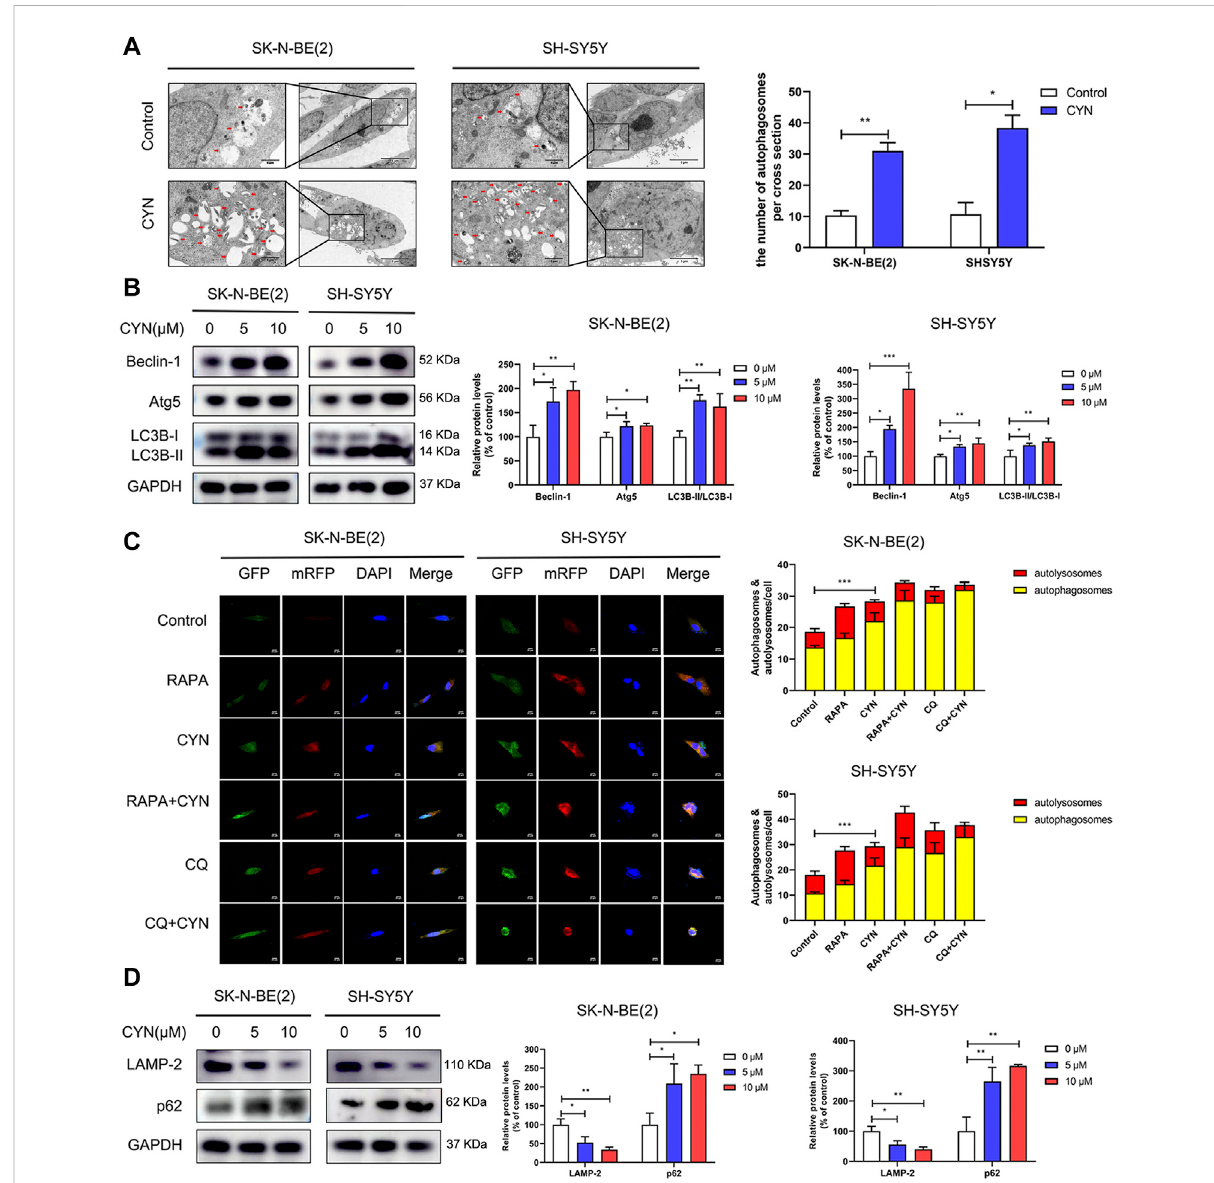
FIGURE 3 Effects of CYN on the autophagy level in NB cells. (A) Transmission electron microscopy (TEM) was utilized to observe the ultrastructure of NB cells, and the arrows indicate autophagosomes. (B) The expression levels of autophagy markers were analyzed by westernblotting. (C) Confocal microscopy was utilized to detect fl uorescence of mRFP-GFP-LC3. (D) Western blotting analysis of LAMP-2 and p62 protein expression. * p < 0.05, ** p < 0.01, *** p < 0.001 versus the control